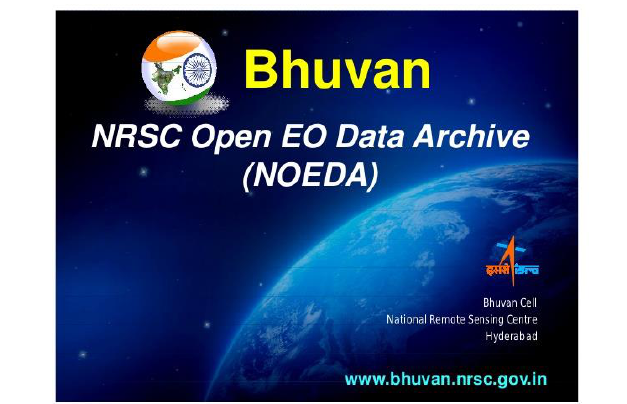
Fig 5. ISRO- NRSC-Bhuvan- Open EO data portal National